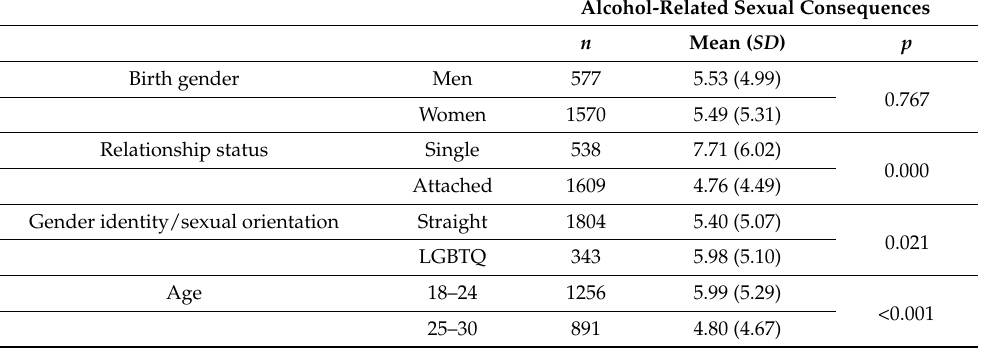
Table 1. By demographic subgroup, comparison of total scores on the Alcohol-Related Sexual Consequences